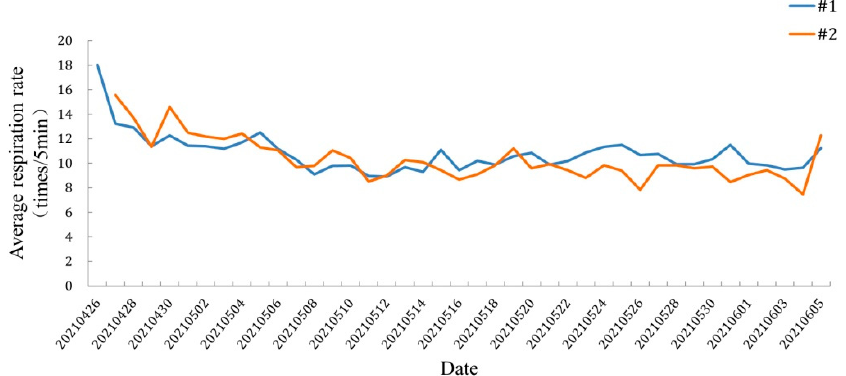
Figure 7. The change curve of respiration rate of six finless porpoises during transient captivity in the holding pens.